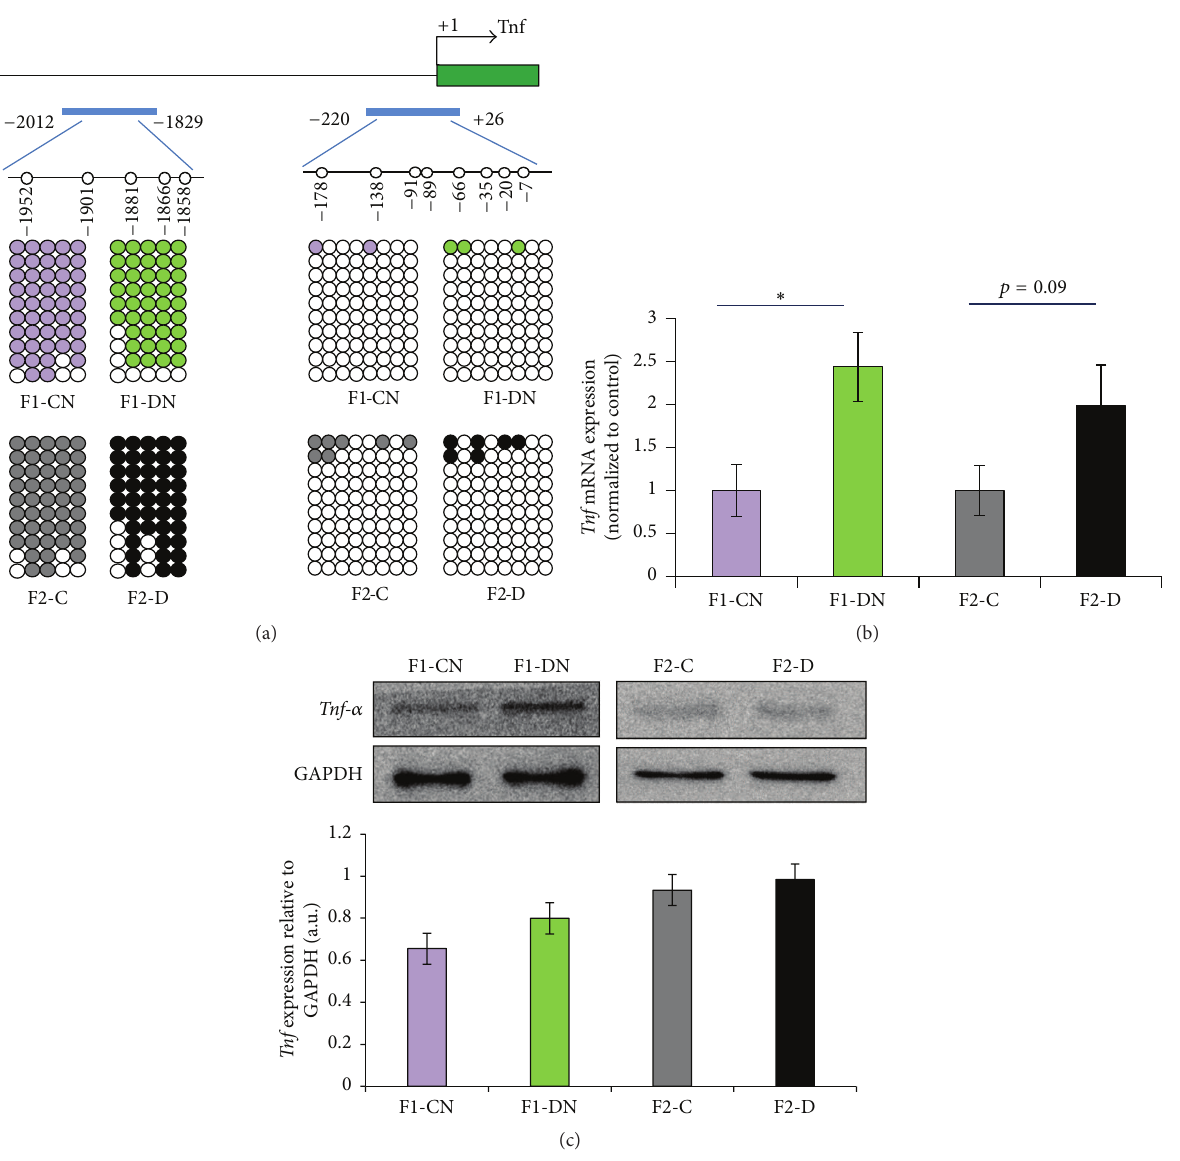
Figure 7: Methylation analysis and gene expression of Tnf . (a) Bisulfite sequencing was performed on the portion of the promoter regions encompassing − 2012 to − 1829 relative to the +1 transcription start site of the Tnf gene including 5 CpG sites and − 220 to +26 including 8 CpG sites. Each line represents the average methylation level of the sequence of all the clones. CpG sites are shown as blank (unmethylated) or filled (methylated) circles ( 𝑁 = 3 per group). (b) The expression of Tnf was identified using real-time PCR ( 𝑁 = 8 -9). (c) The protein expression of Tnf was identified using Western blotting ( 𝑁 = 5 per group). Results are presented as the means ± SEM. ∗ 𝑝 < 0.05 versus F1-CN. 𝑁 =